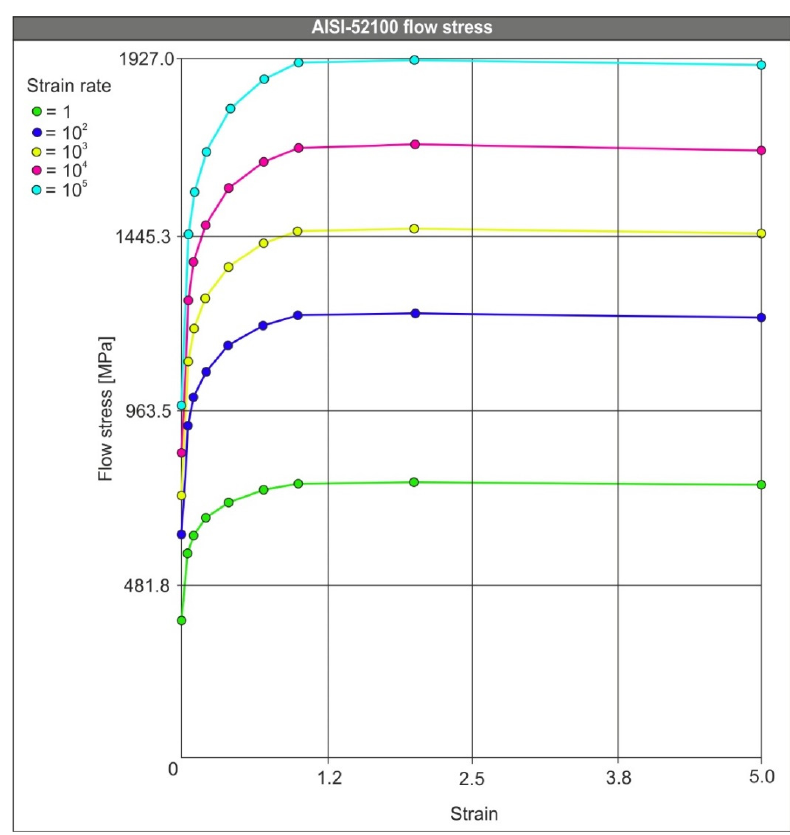
Figure 3. The flow stress diagram [28] for AISI-52100 steel at 20 °C.